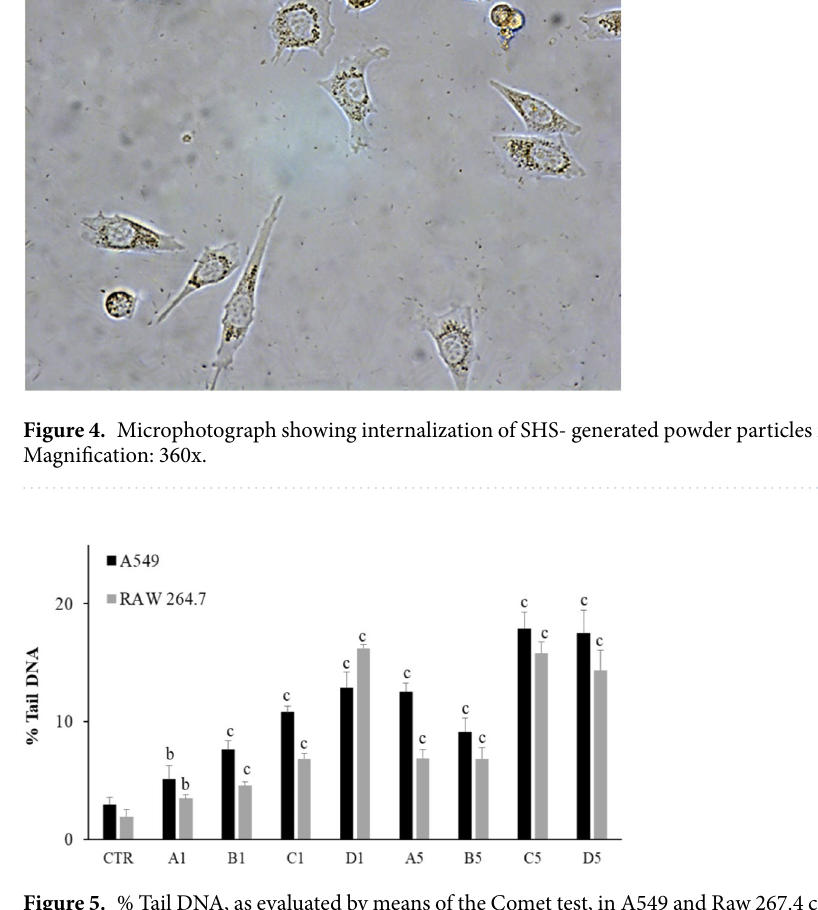
Figure 5. % Tail DNA, as evaluated by means of the Comet test, in A549 and Raw 267.4 cells after exposure for 12 h to the lowest (0.33 µ g/ cm 2 ) and to the highest concentrations (15.62 µ g/cm 2 ) either of slag powder particles or of asbestos. The columns report the means + SD of triplicate analyses. Statistical analysis: b P < 0.01 and c P < 0.001 vs .